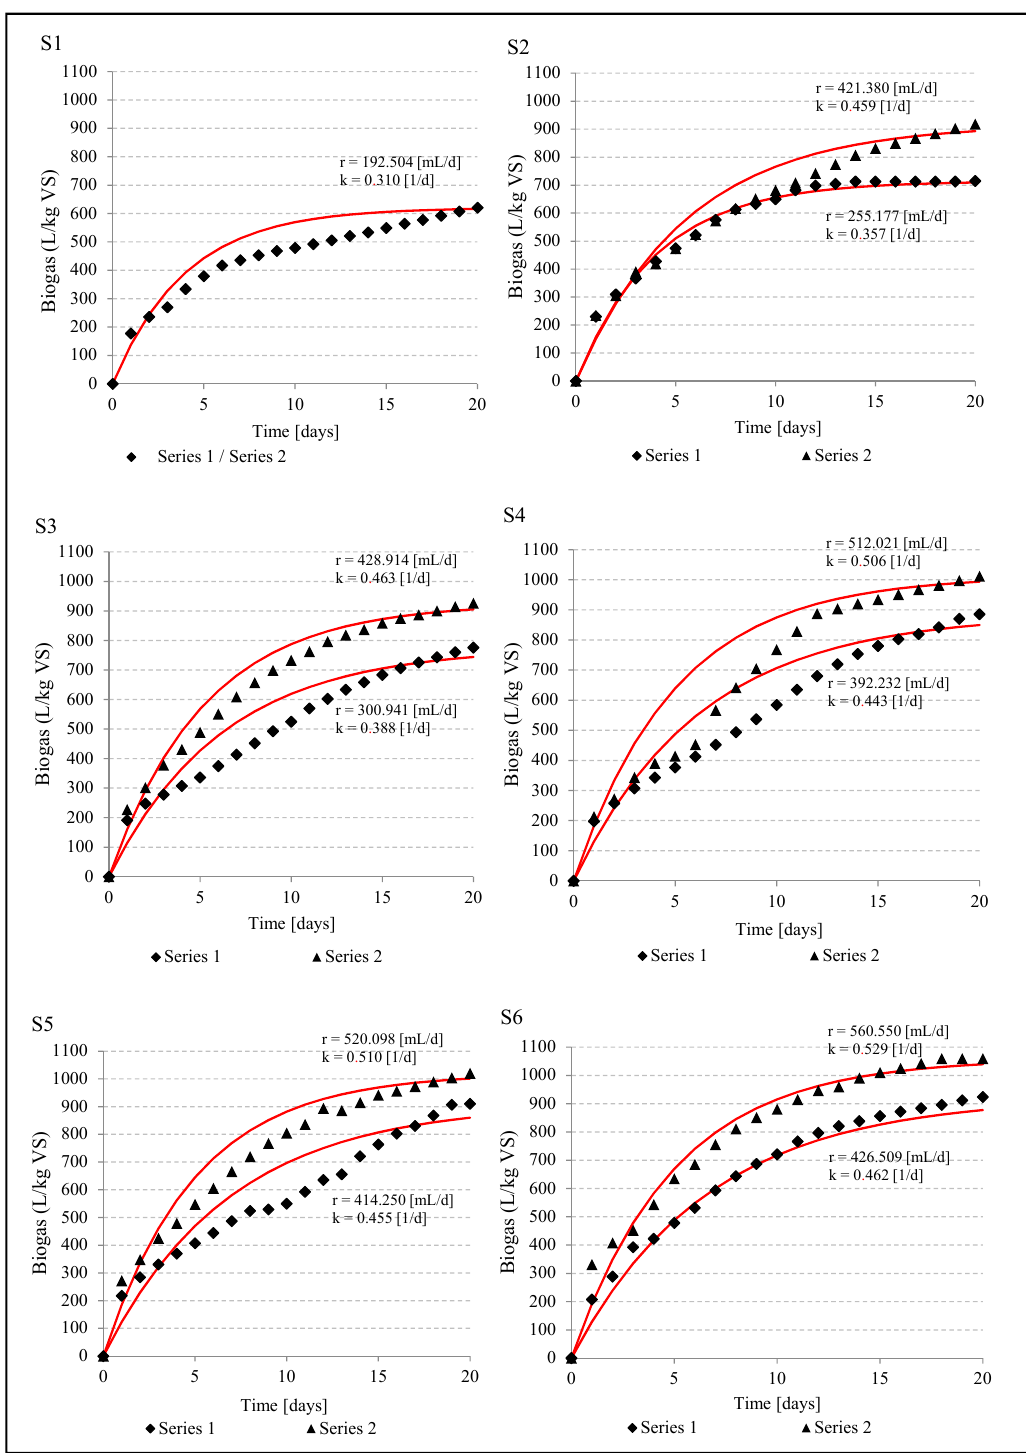
Figure 1. Biogas production in batch AD assays over time in experimental setups (S) .